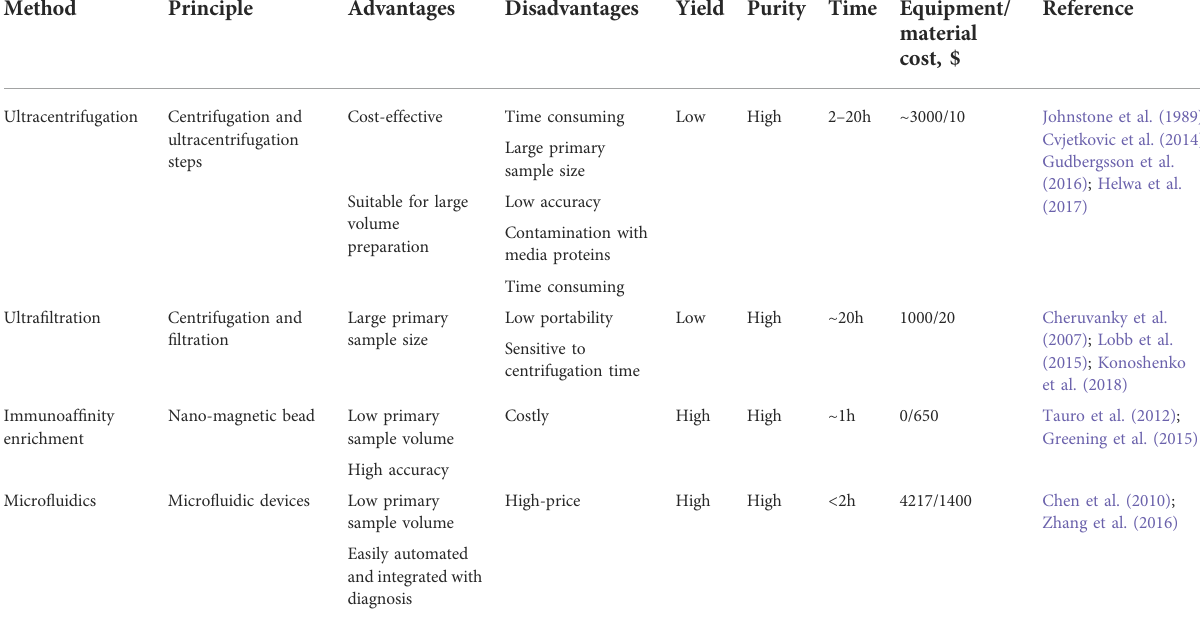
TABLE1 Comparison of the current exosome extraction